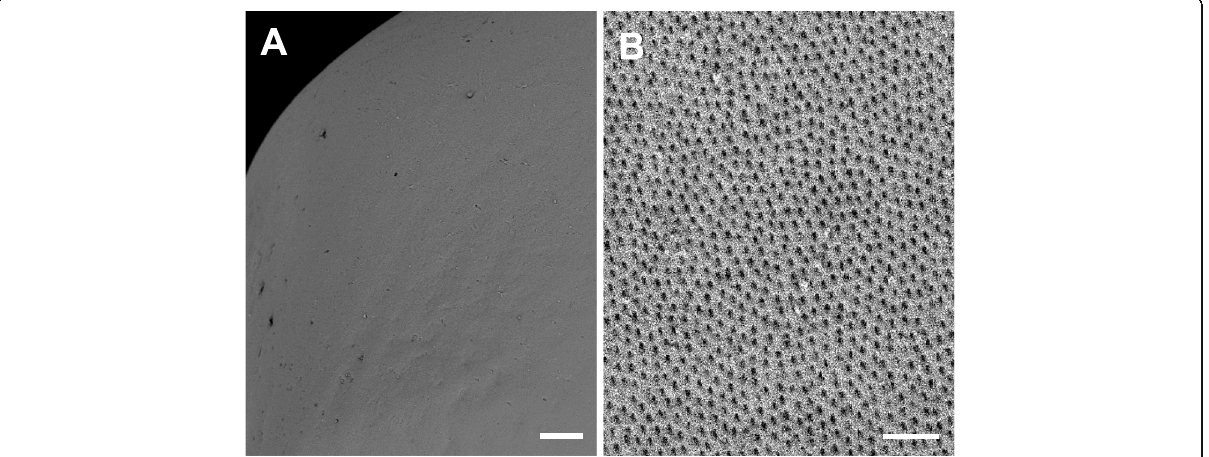
Fig. 3 Scanning electron micrographs of outer ( a ) and inner surfaces ( b ) on the fertilized egg envelopes of A. cirrhosus . The outer surface is smooth. And the grooves were distributed on the inner surface (Scale bar = A; 100 μ m, B; 4 μ